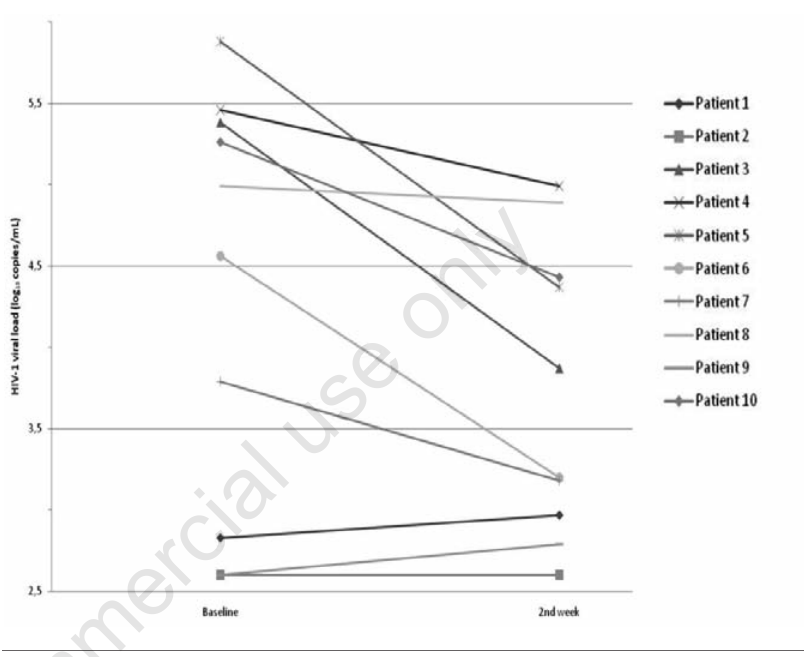
Figure 1. Evolution of cerebrospinal fluid HIV-1 viral load in patients with cryptococcal meningitis from baseline to the second week of antifungal therapy.